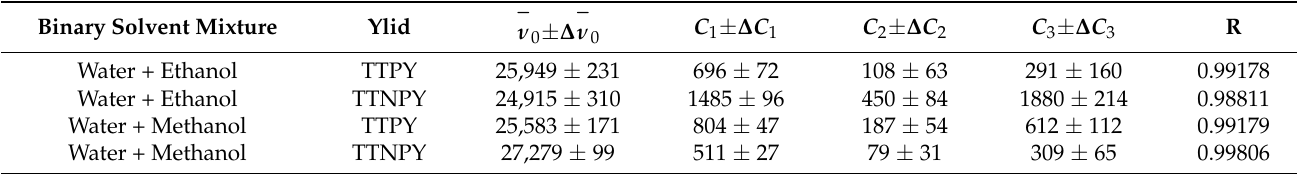
Table 3. Regression parameters in relation ν the binary solvent mixtures solutions of 4-tolyl-1,2,4-triazol-1-ium phenacylid (TTPY) and 4-tolyl-1,2,4-triazol-1-ium-4 (cid:48) - nitro-phenacylid (TTNPY), respectively, with parameters from Tables 1 and 2. Binary Solvent